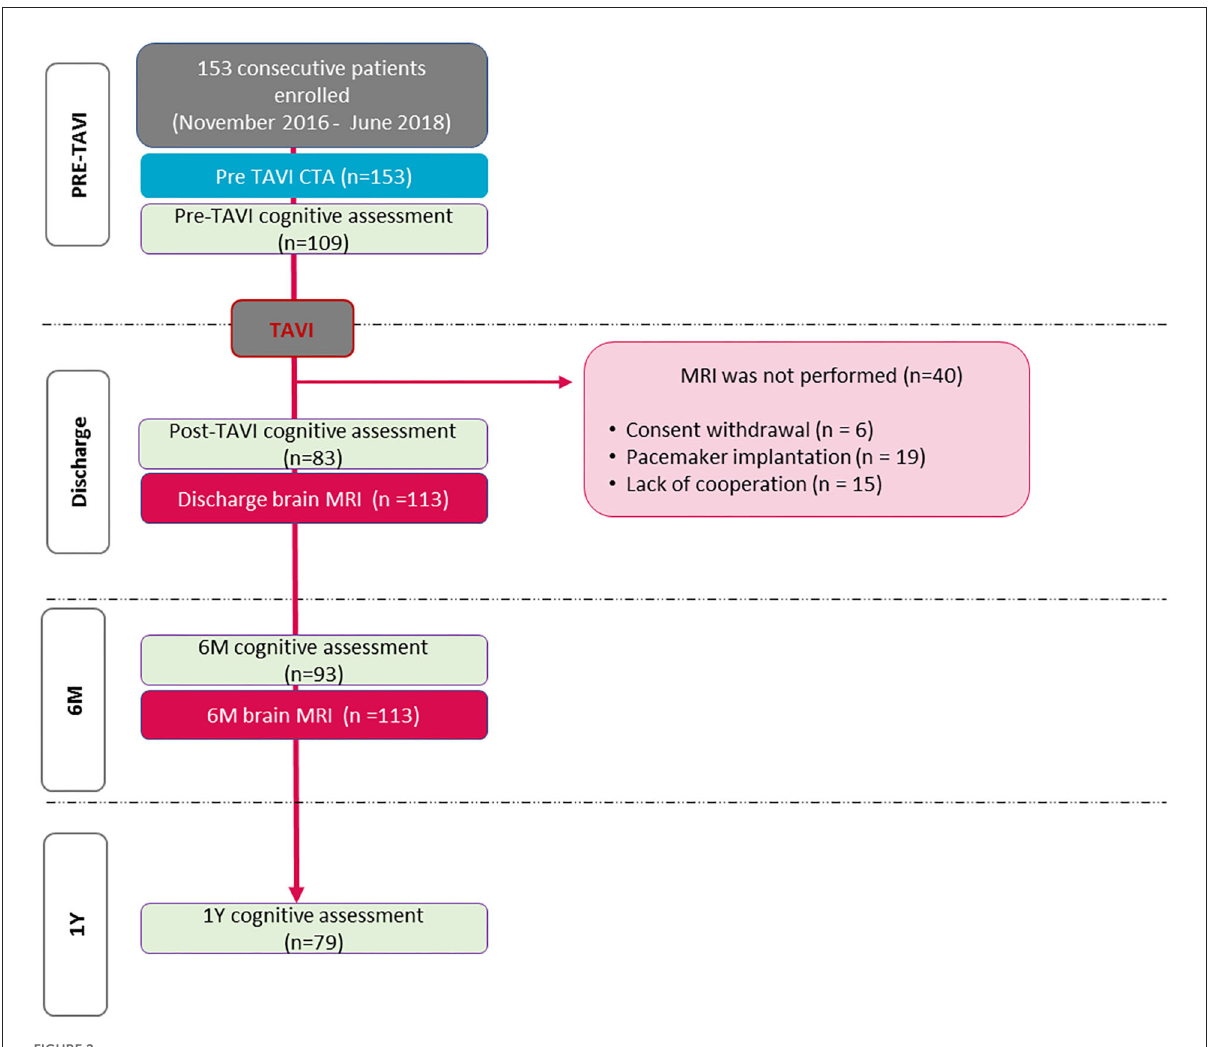
FIGURE2 Flowchart of the